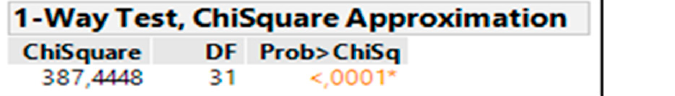
Figure 6. Analysis of water productivity variability according to EU member states–results of Kruskal-Wallis test.